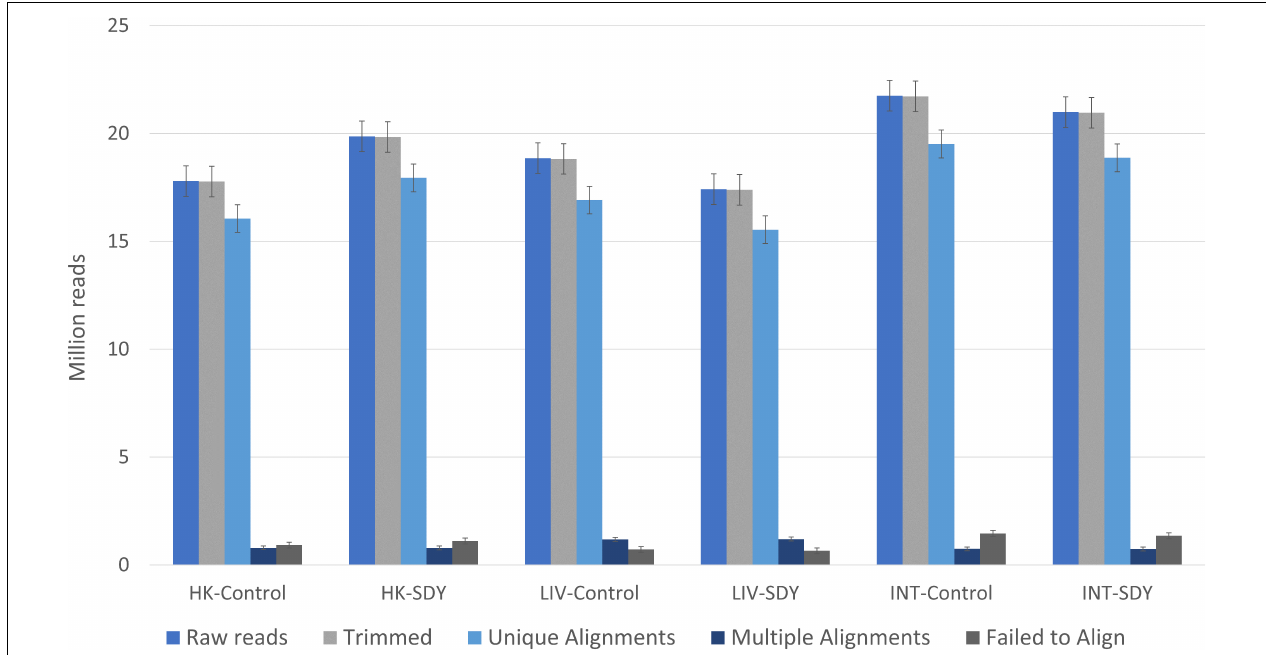
FIGURE 1 | Number of reads obtained by RNA-seq (raw reads, trimmed reads, unique alignment reads, multiple alignment reads, and reads that failed to align) for each of the targeted tissues (head kidney, liver, and anterior-mid intestine) of gilthead sea bream ( Sparus aurata ) in response to the control (Control) and the Brewer’s SDY diets. The error bar represents the standard deviation of the mean values obtained for each tissue ( n = 5 replicates). HK, head kidney; LIV, liver; INT, anterior-mid